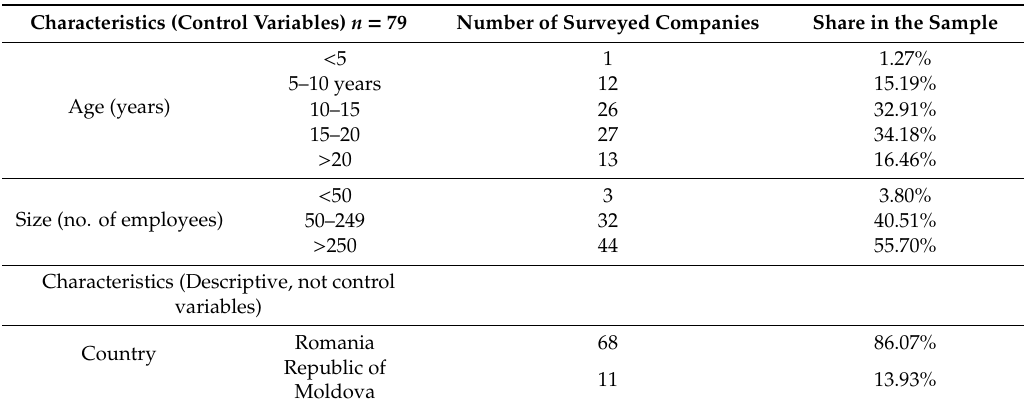
Table 8. The sample structure.